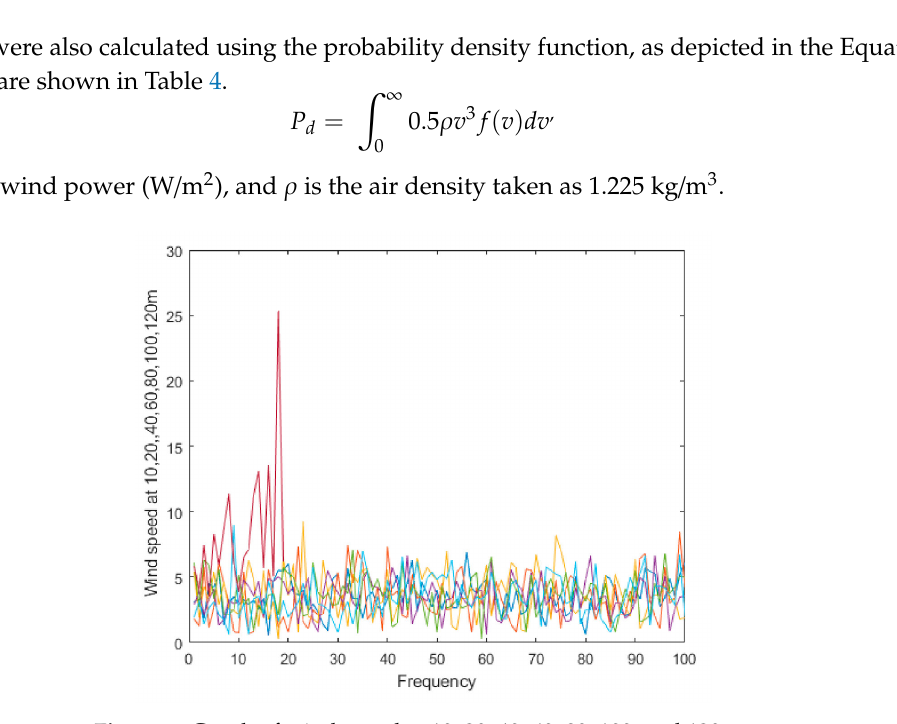
Figure 1. Graph of wind speed at 10, 20, 40, 60, 80, 100, and 120 m. Table 4. Weibull parameters and mean power densities at di ff erent